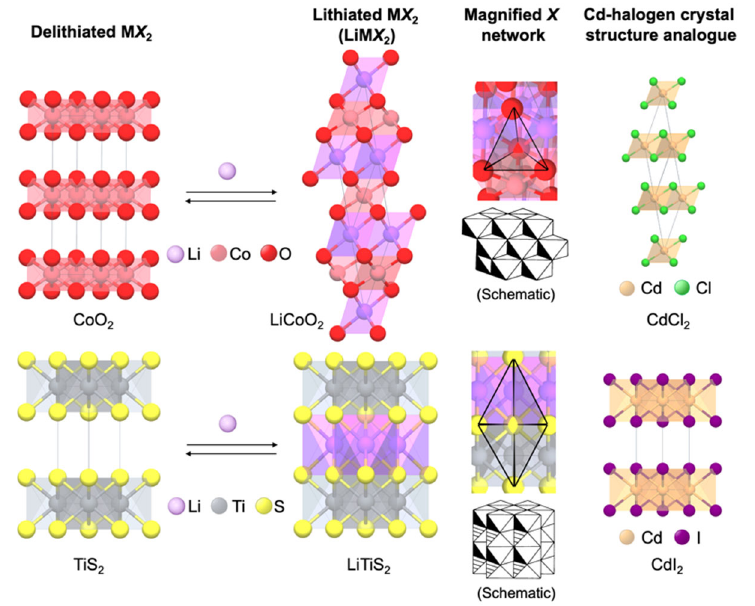
Figure 3. Comparison of the crystal structures [41] of the delithiated and lithiated CoO 2 and TiS 2 , which are analogous to the crystal structures of the close ‐ packed pseudocubic array of CdCl 2 and close ‐ packed hexagonal array CdI 2 , respectively.